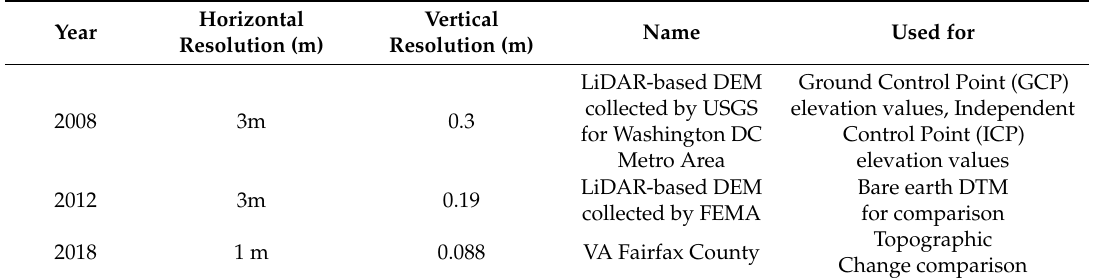
Table 1. Reference digital elevation datasets.